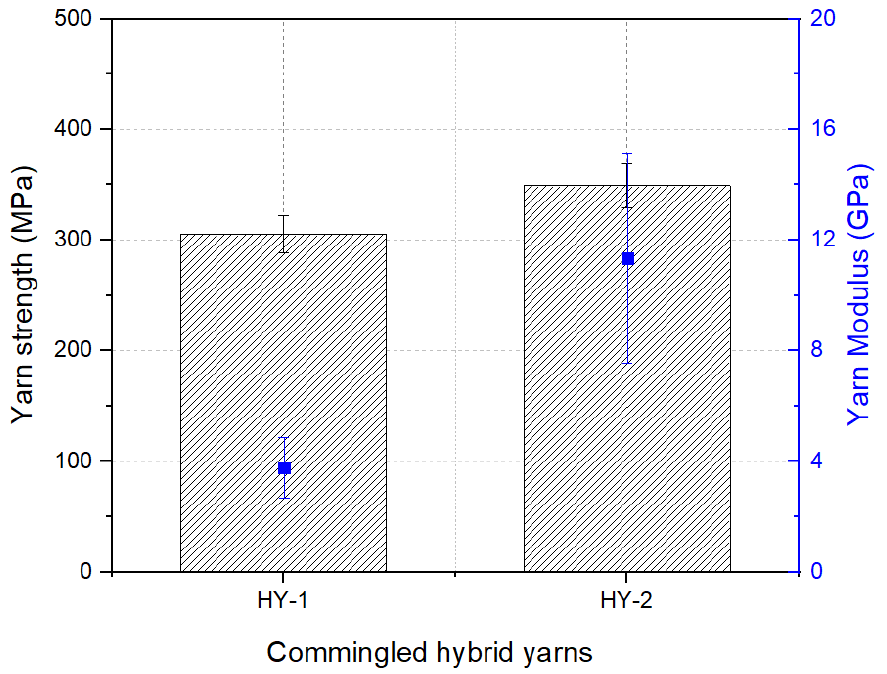
Figure 9. Tensile properties of GF/stainless-steel/PA-6 commingled yarns.